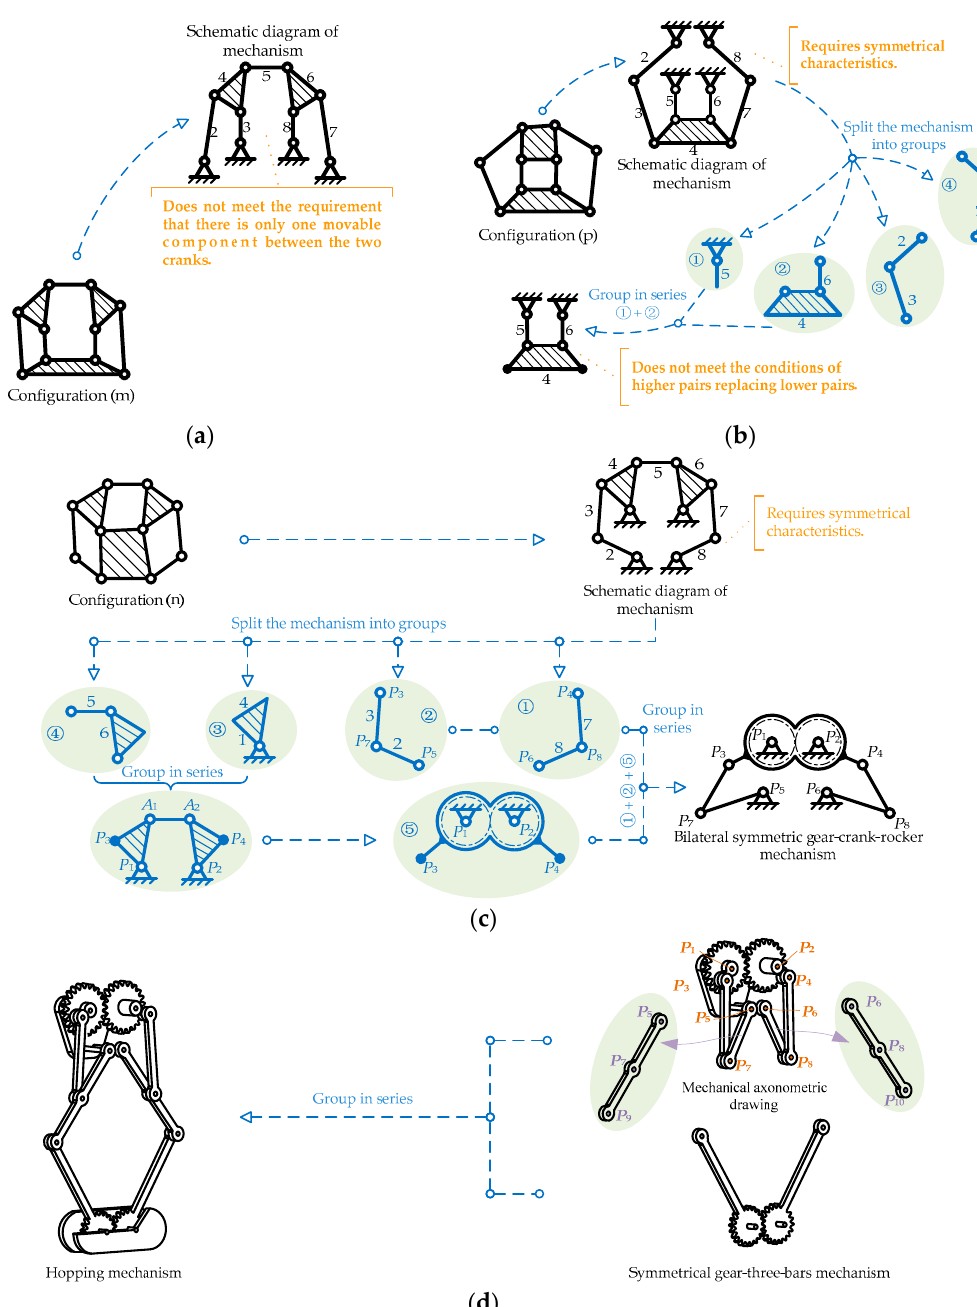
Figure 4. Configuration evolution of the eight-bar mechanism. ( a ) The evolution of the configuration (m). ( b ) The evolution of the configuration (p). ( c ) The evolution of the configuration (n). ( d ) The process of structural improvement.